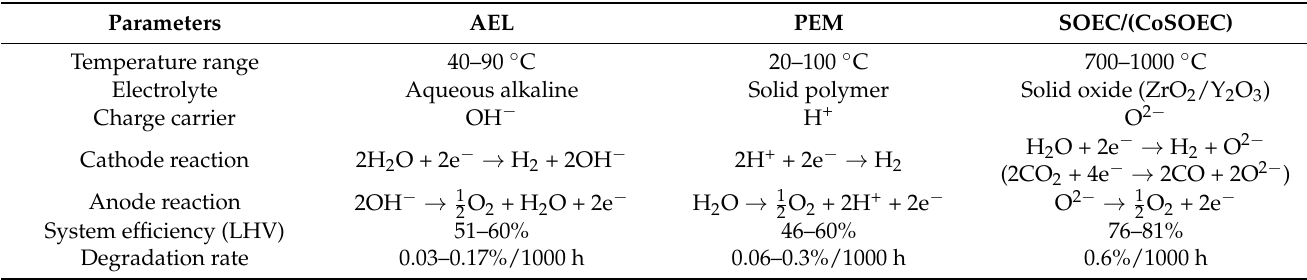
Table 1. Overview of the three leading electrolysis technologies (adapted from [23]).